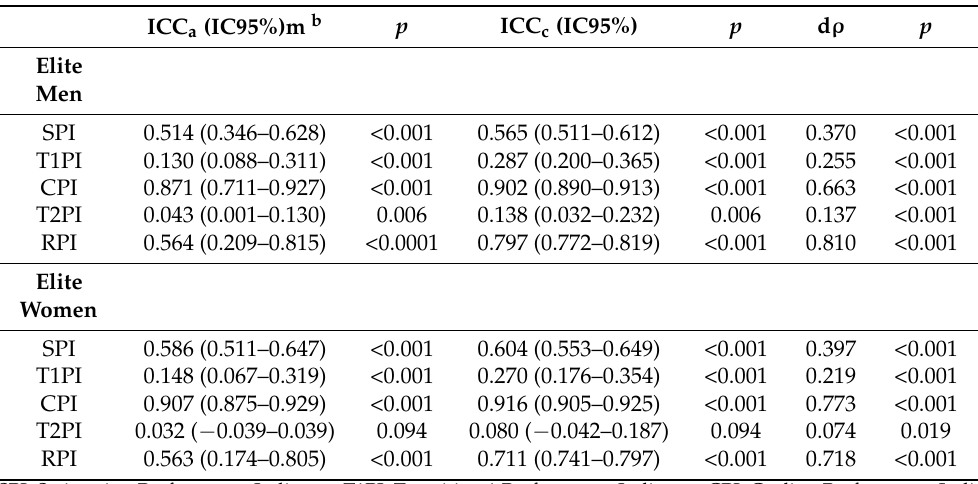
Table 1. Intraclass correlation coefficient of absolute agreement and concordance, and Spearman range correlation coefficient between the overall performance indicator and the three segments in the years